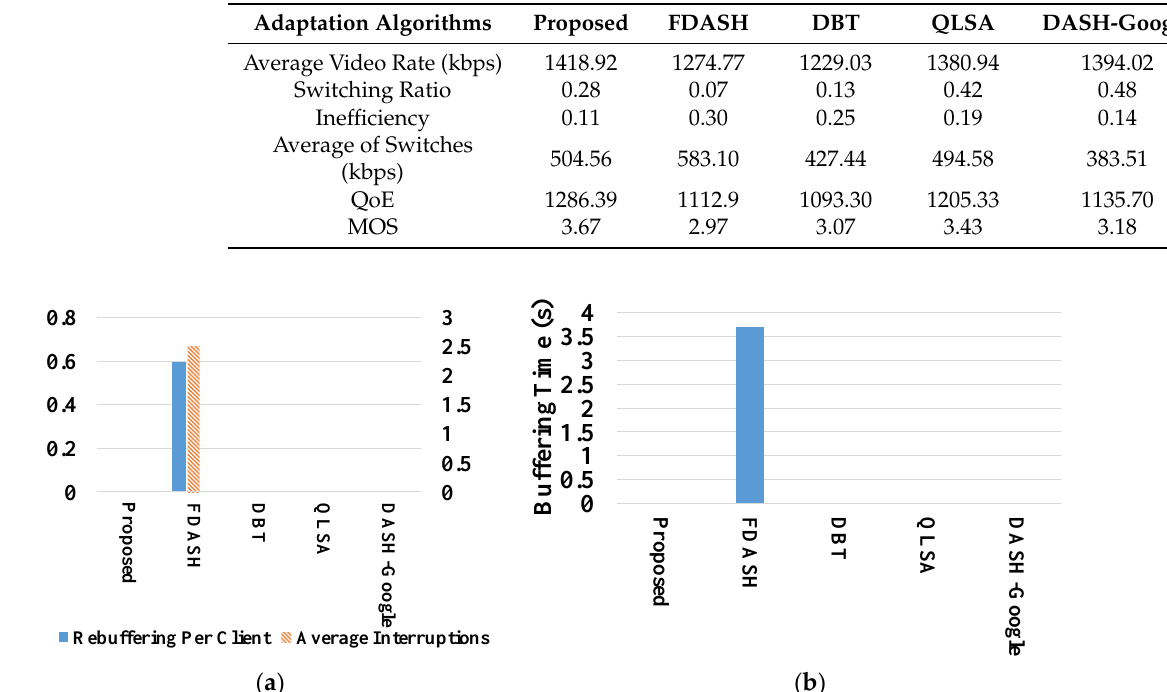
Table 7. Performance of algorithms at a buffer size of 15 s and a segment duration of 2 s.